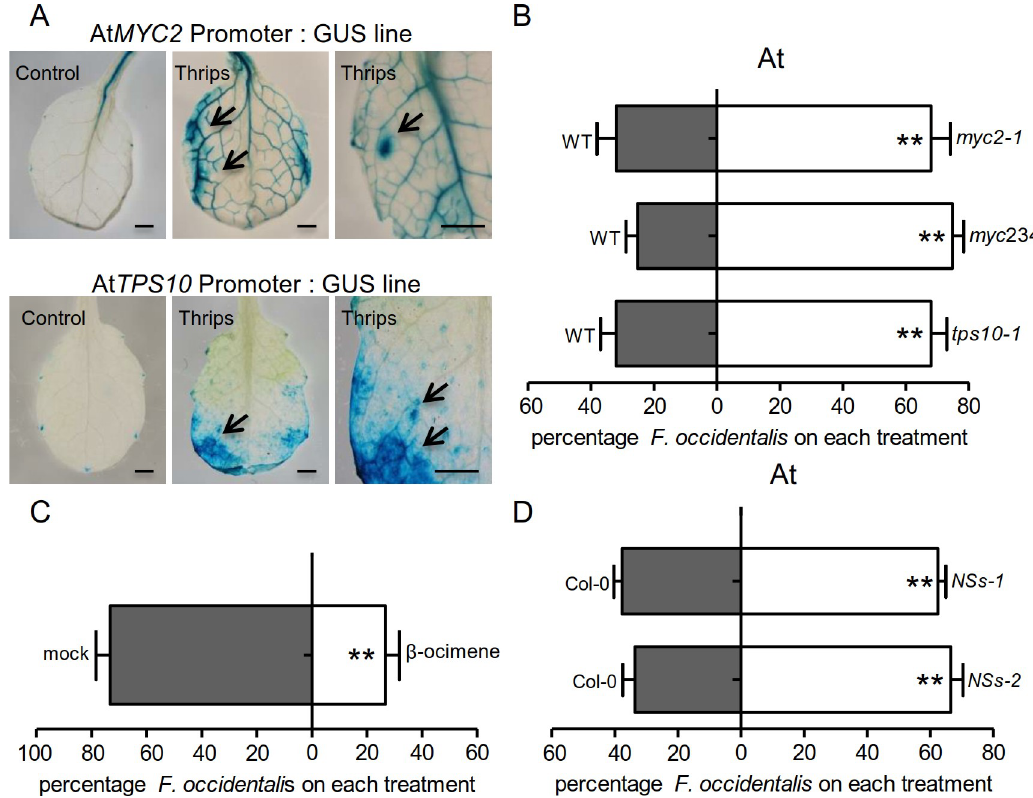
Fig 5. MYC2 and its homologs in Arabidopsis are essential regulators of host immunity responses against WFT. (A) GUS staining of AtMYC2p-GUS and AtTPS10p - GUS seedlings after 24 h of thrips feeding. An untreated line was used as a control. Arrows indicate thrips feeding sites. Bars = 2 mm. (B) Thrips preference (as percentage recaptured WFT out of 50 released) between the mutants and WT control in a two-choice assay. Three-week-old Arabidopsis plants cultured in MS medium were used for the thrips two-choice assay. Data are mean percentages + SE, n = 6. �� P < 0.01, Wilcoxon matched pairs tests. (C) β - ocimene is less attractive to thrips than mock treatment in a two-choice assay. Data are mean percentages + SE, n = 6. �� P < 0.01, Wilcoxon matched pairs tests. (D) Thrips preference (as percentage recaptured WFT out of 50 released) between the 35S : YFP-NSs transgenic Arabidopsis lines ( NSs-1 ; NSs-2 ) and mock control in a two-choice assay. Three-week-old transgenic Arabidopsis plants cultured in MS medium were used. Data are mean percentages + SE, n = 6. �� P < 0.01, Wilcoxon matched pairs